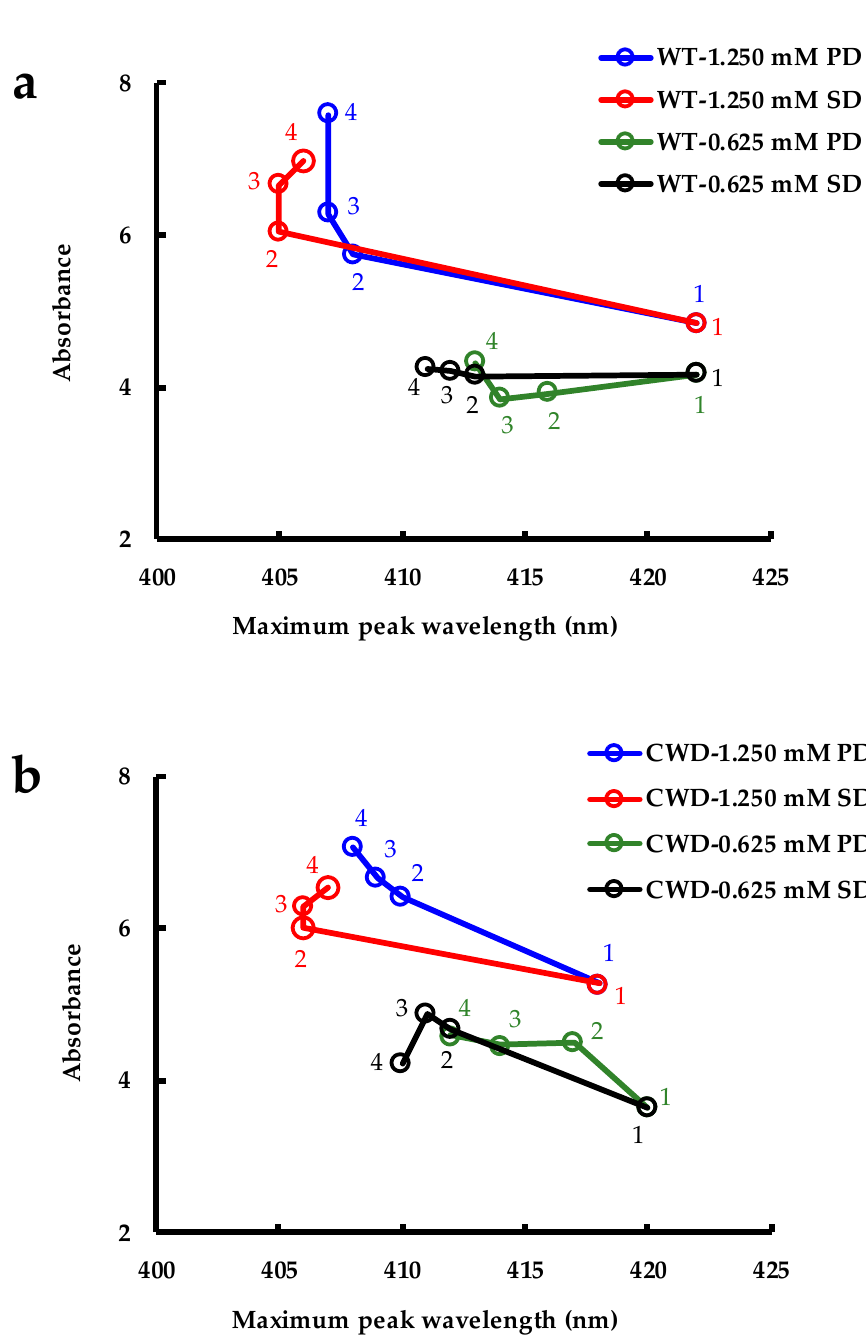
Figure 8. Stability of AgNPs produced by: ( a ) WT strain at 1.250 mM and 0.625 mM AgNO 3 concentrations after NaCl addition at physiological dose (PD, 9 g L − 1 ) and sea-water dose (SD, 27 g L − 1 ); ( b ) CWD strain at 1.250 mM and 0.625 mM AgNO 3 concentrations after NaCl addition at physiological dose (PD, 9 g L − 1 ) and sea-water dose (SD, 27 g L − 1 ) (1: before adding NaCl (t = 0); 2: after adding NaCl (t = 15 min); 3: after 18 h; and 4: after 72 h).